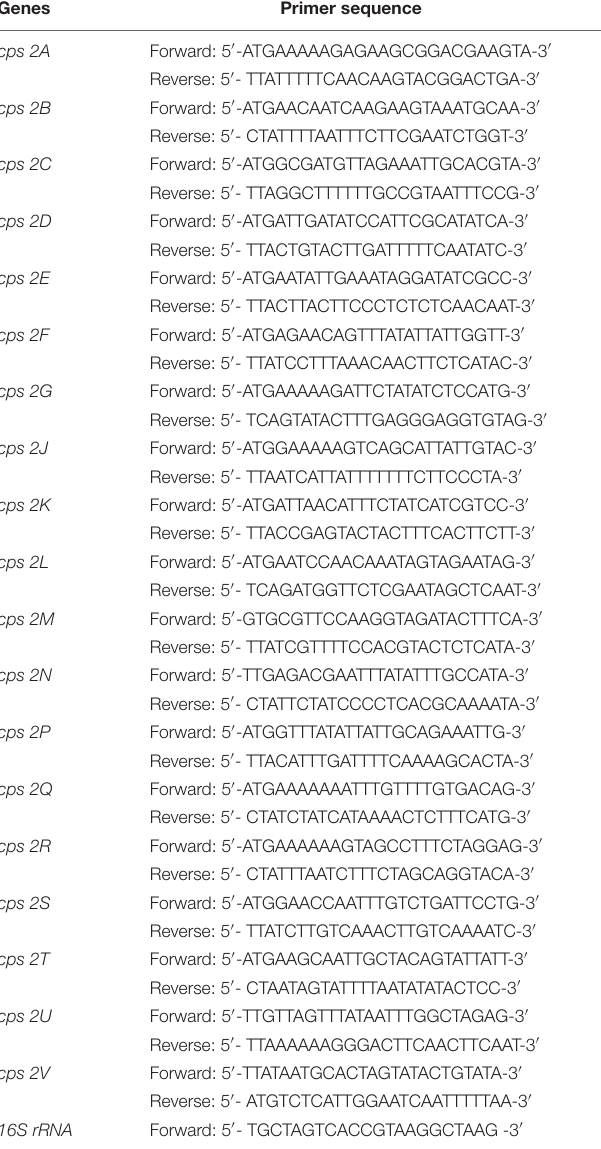
TABLE 2 | Primers used for the quantitative RT-PCR analysis. Genes Primer